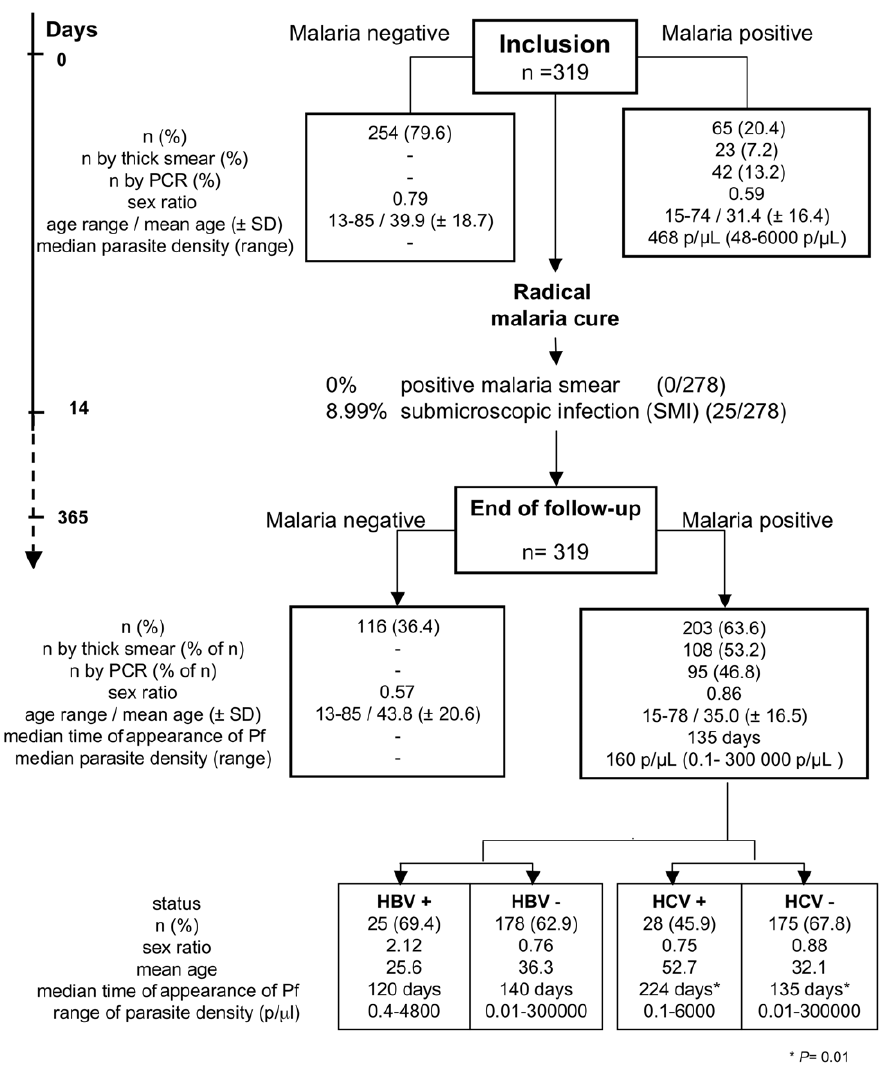
Figure 1. Schematic representation of the study. The flow chart represents the total number of patients enrolled, and analyzed, and the status of all patients at one-year follow-up.